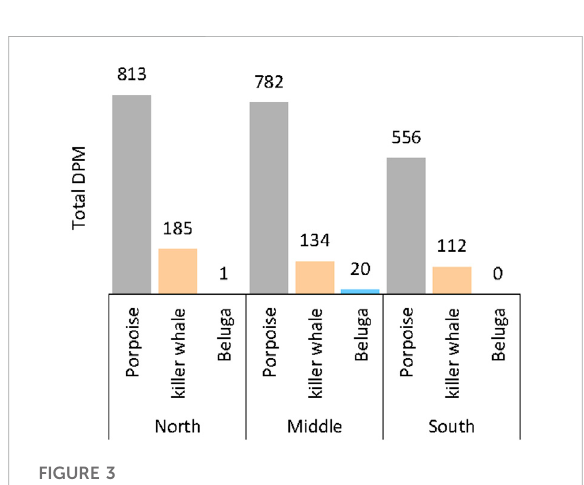
FIGURE 3 Total number of detection positive minutes (DPM) for each species detected at the three mooring stations in Krusenstern Point, Kotzebue Sound, Alaska, during the summer 2013 pilot